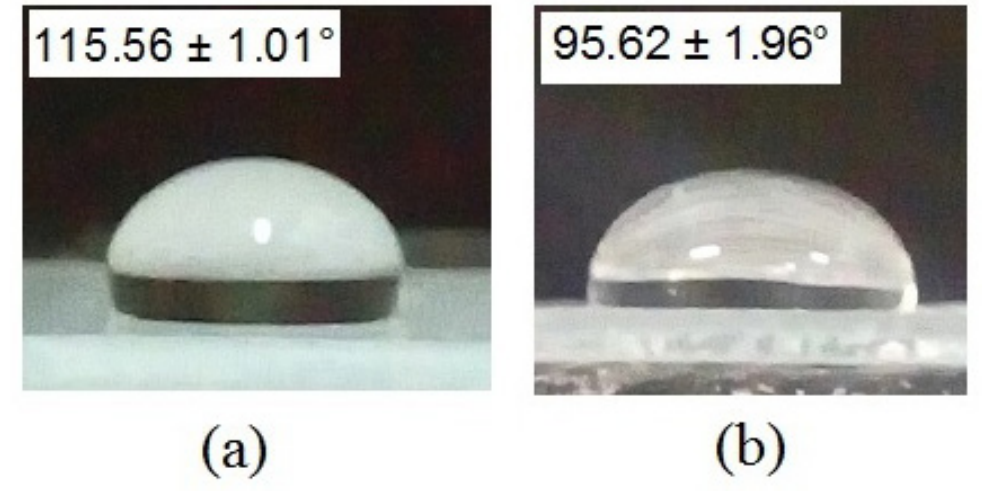
Figure 4: The image of water droplet on (a) STM and (b) TMS coated glass.